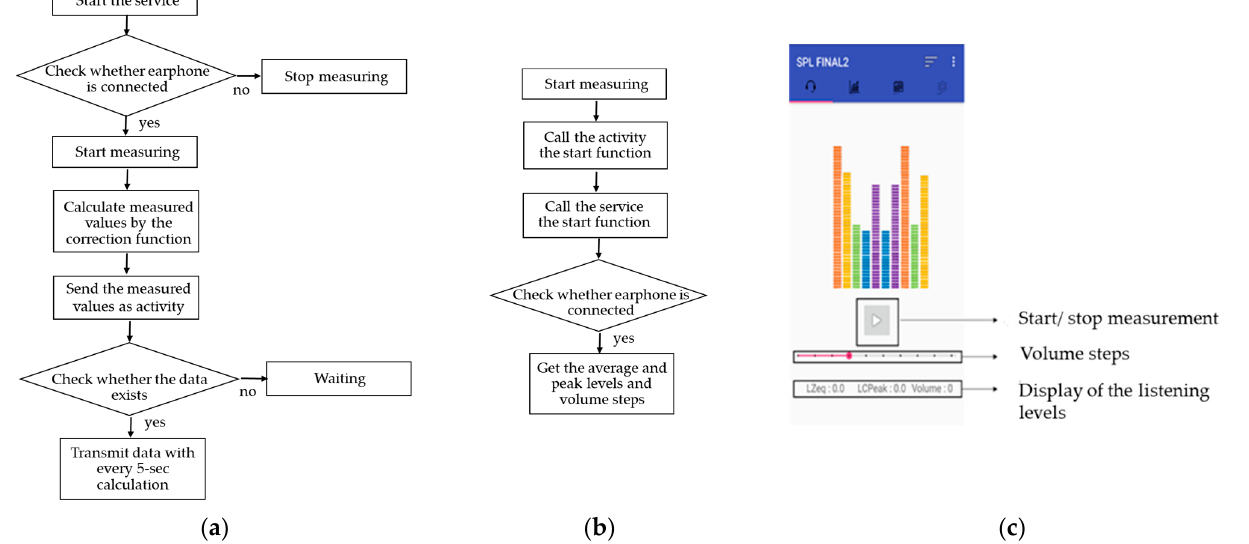
Figure 1. A flow chart showing the components of background service ( a ) and active processing ( b ), and a screenshot of the measurement application used in the current experiment using the developed application ( c ).